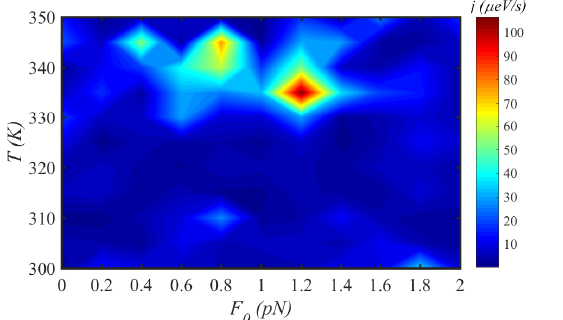
Figure 8. The energy flux j map through a N = 150 site protein chain under the simultaneous effects of temperature T and magnitude F 0 of the external mechanical load at a fixed force frequency, ω = 0.1